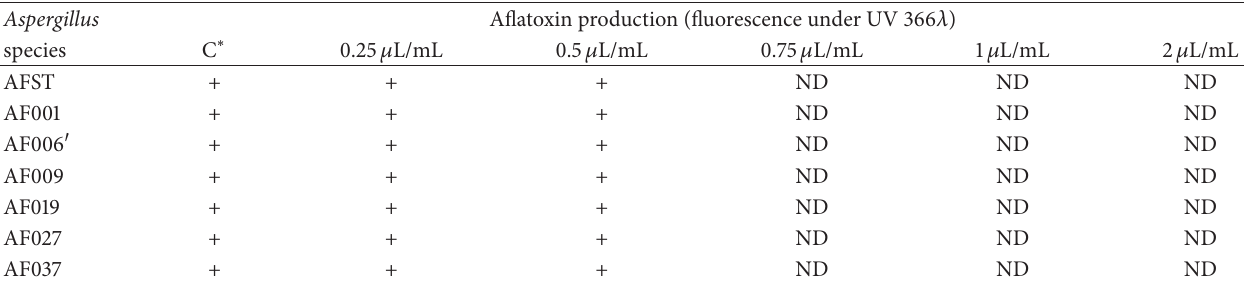
Table 7: Antiaflatoxigenic activity of Trachyspermum ammi essential oils at a concentration of 0.00, 0.25, 0.5, 0.75, 1, and 2 𝜇 L/mL against toxigenic Aspergillus species.